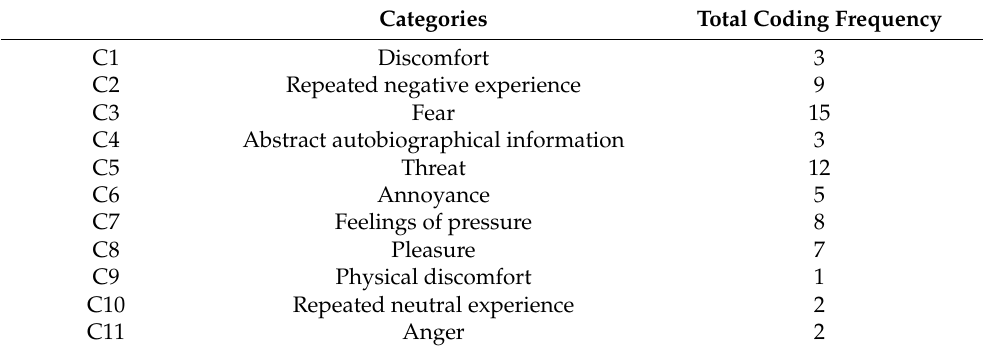
Table 3. Categories pertaining to participants’ psychological associations of everyday sounds and total coding frequency.